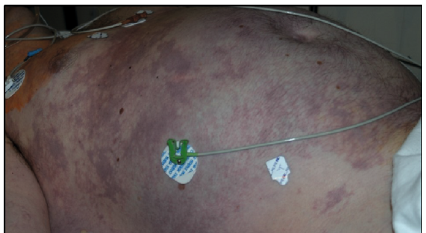
Figure 1: Cutis marmorata, a rash typically associated with severe decompression sickness, was present on arrival to the hyperbaric chamber.